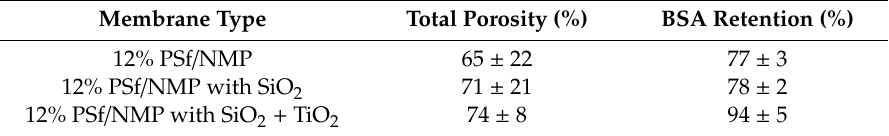
Table 3. Bovine serum albumin (BSA) retention onto polysulfone composite membranes. Membrane Type